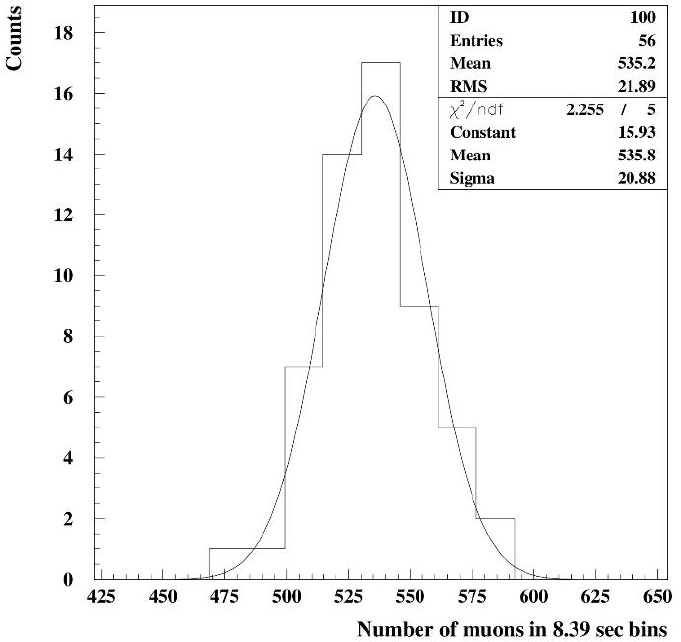
Figure 5. The distribution of background events in the sky cell No. 48 obtained from the 12 hours’ data before 21:00 UT on 8th November 2000. There were 373 muons plus and 261 muons minus out of the 634 muons in sky cell No. 48 and in the 8.39 min live-time bin at 00:07 UT on 9th November 2000. The charge ratio of muons was about 1.43 and the distribution of their momenta up to 100 GeV/c is shown in Figure 6.